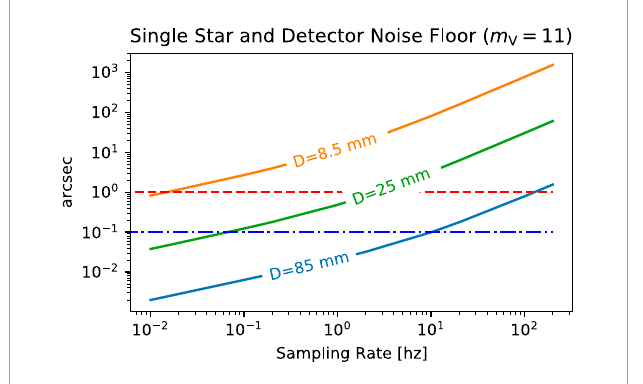
FIGURE 6 Attitude sensing limit curves assuming centroiding noise due to photon statistics and detector noise from the TRL-9 MT9P031 CMOS detectors widely used on nanosatellites. For an 85-mm space telescope, sub-arcsec sensing is readily achieved at 100 s sampling or slower rates, implying that ∼ 10 Hz bandwidth controllers are as fast as is feasible on dim